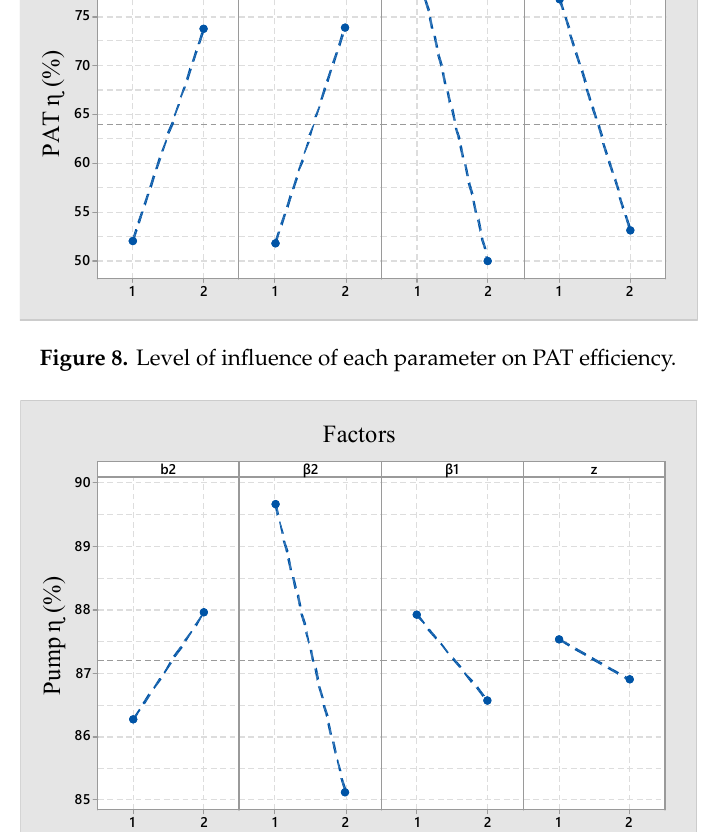
Figure 9. Level of influence of each parameter on pump efficiency.